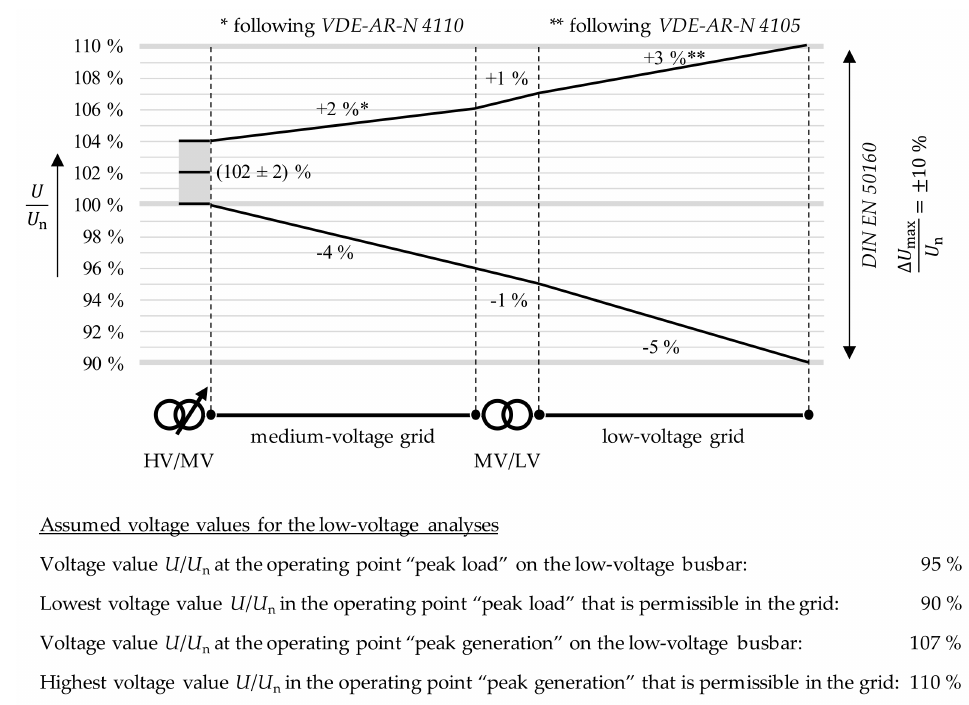
Figure 8. Assumed voltage band